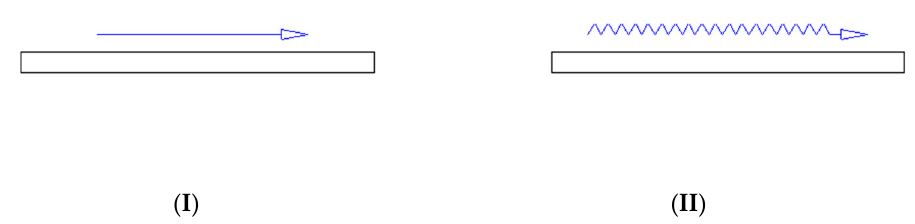
Figure 4 . The comparison of product movement between a shaken conveyor and a vibrating Figure 4. The comparison of product movement between a shaken conveyor and a vibrating conveyor. conveyor. I — shake conveyor — product movement. II — vibrating conveyor — product movement. ( I )—shake conveyor—product movement. ( II )—vibrating conveyor—product